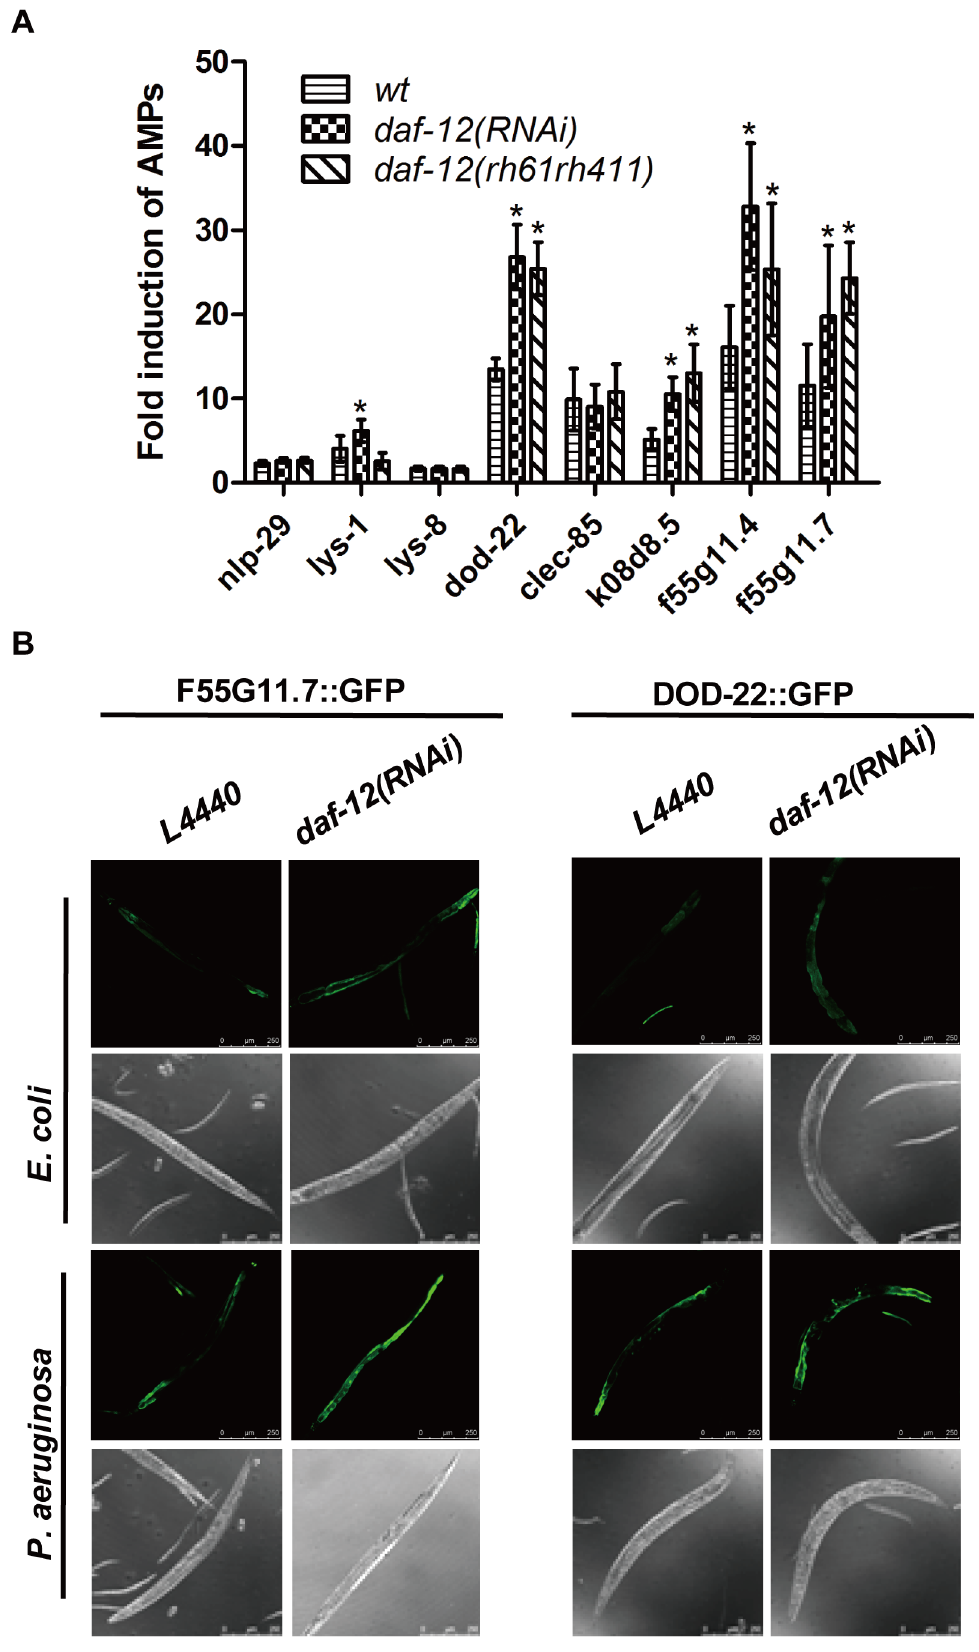
Figure 2. DAF-12 regulates antimicrobial gene expression. ( A ) qRT-PCR analysis of anti-microbial peptide (AMP) gene expression in N2, daf- 12 (RNAi) and daf-12 ( rh61rh411 ) worms infected with P. aeruginosa for 24 hours. The data shown are the mean 6 SEM of three independent experiments, eachof which was performed intriplicate, * P , 0.05. ( B ) Confocal microscopyof daf-12 RNAi-treated orcontrol RNAi-treated dod-22::GFP and F55G11.7::GFP worms on E. coli or P. aeruginosa for 24 hours. The data are representative of three independent experiments (n $ 50 adult nematodes per strain). doi:10.1371/journal.ppat.1003545.g002 PLOS Pathogens | www.plospathogens.org